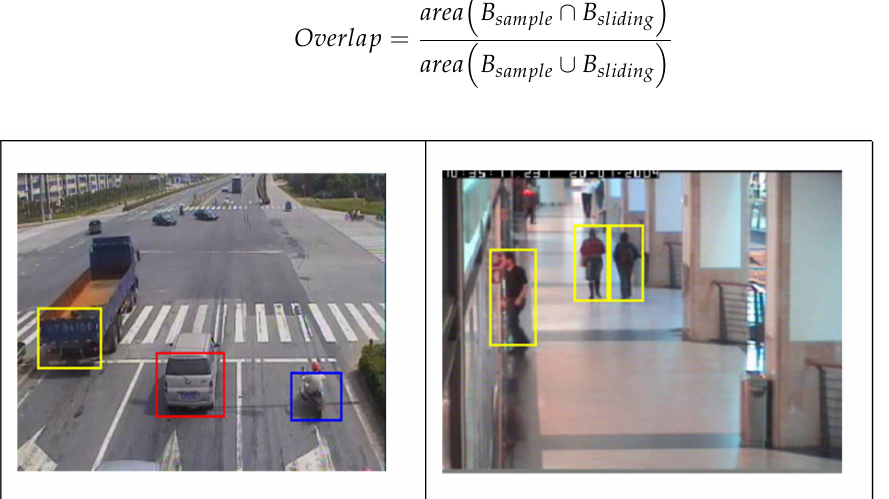
Figure 2. Illustration of labeling detection